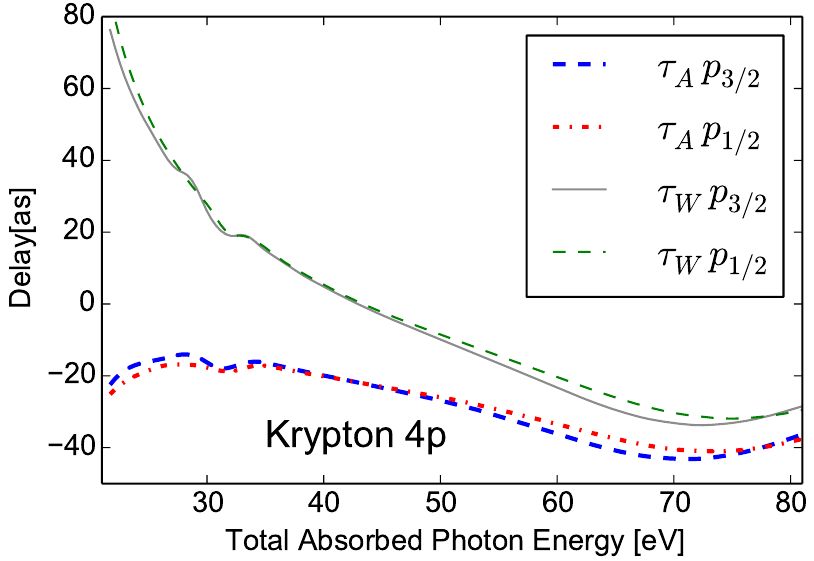
Figure 3. The atomic and Wigner delay calculated in length gauge for ionization from Kr 4 p j , for electrons emitted along the polarization axis. The thick dashed blue line shows the atomic delay for electrons ionized from 4 p 3/2 , and the dotted–dashed red line shows the atomic delay for electrons ionized from 4 p 1/2 . The thin dashed green and solid grey lines show the Wigner delay for electrons ionized from 4 p 1/2 and 4 p 3/2 respectively. Dirac–Fock orbital energies have been replaced with experimental ionization energies: For 4 p 3/2 the binding energy is 14.00 eV, and for 4 p 1/2 it is 14.67 eV [94]. Dirac–Fock orbital energies are used for the deeper lying orbitals.